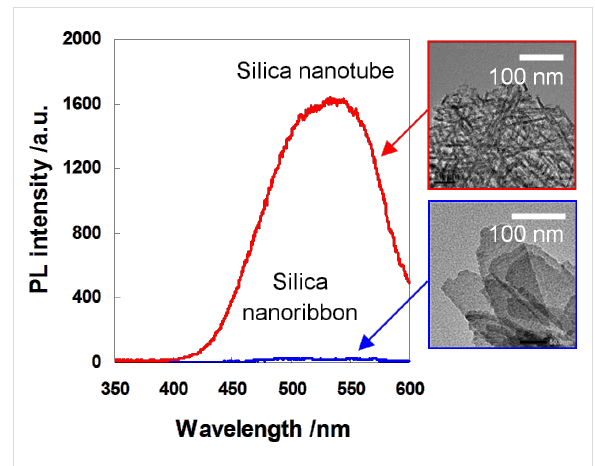
Figure 8: Phosphorescence emission spectra ( λ Ex = 320 nm) of silica nanotubes and nanoribbons that were synthesized by calcining the corresponding LPEI@silica hybrid nanotubes (Figure 1A–C) and nanoribbons (Figure 1D–F) under N 2 atmosphere at 1000